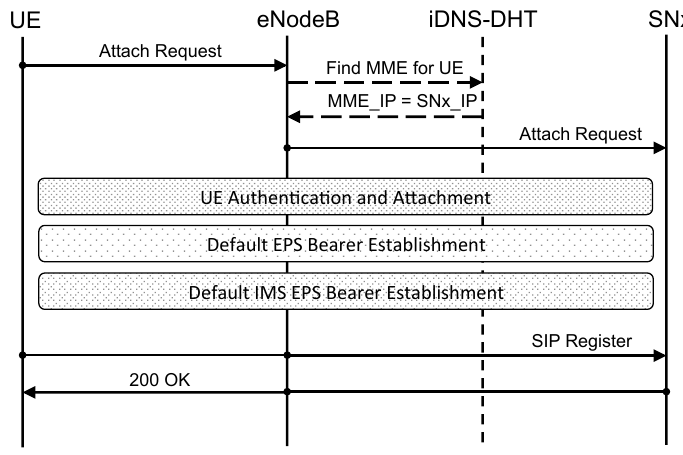
Figure 11. UE attach and SIP registration with